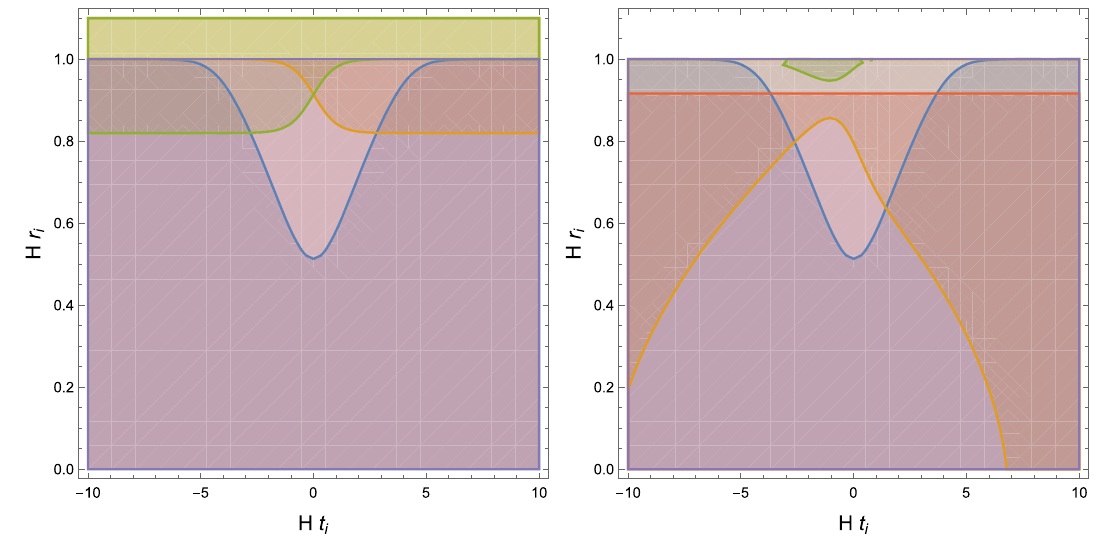
Fig. 8 Regions satisfying three conditions. We set cG ( 3 ) H /( 6 π) = isfying condition 1, ∂ U S gen ( I ) ≥ 0 in condition 2, ∂ V S gen ( I ) ≤ 0 in 0 . 09 and G ( 3 ) H = (cid:10) UV H = 0 . 1. (Left): Constant central charge condition 2, ∂ U S gen ( G ) ≤ 0 in condition 3, and ∂ V S gen ( G ) ≥ 0 in con- ( dc / dt = 0 ) case. Regions satisfying condition 1, ∂ ( I ) ≥ 0 dition 3 are colored in blue, orange, green, red, and purple, respectively. i U S gen The nonzero dc / dt i makes two inequalities in condition 3 different, as in condition 2, ∂ V S gen ( I ) ≤ 0 in condition 2 and condition 3 are col- ored in blue, orange, green, and red, respectively. The region allowed by canbefoundfromthereductionoftheregionsatisfying ∂ U S gen ( G ) ≤ 0. all three conditions does not exist, especially because ∂ U S gen ( I ) ≥ 0 While the region satisfying ∂ U S gen ( I ) ≥ 0 in condition 2 is enhanced, and ∂ V S gen ( I ) ≤ 0 in condition 2 are satisfied simultaneously only the region satisfying ∂ V S gen ( I ) ≤ 0 in condition 2 shrinks and becomes for Ht i (cid:11) 0 and Hr i (cid:3) 1, which is excluded by condition 1. (Right): exclusive to ∂ U S gen ( G ) ≤ 0. The region satisfying all three conditions Evolving central charge case with ( dc / dt i )/( cH ) = 0 . 5. Regions sat- does not exist